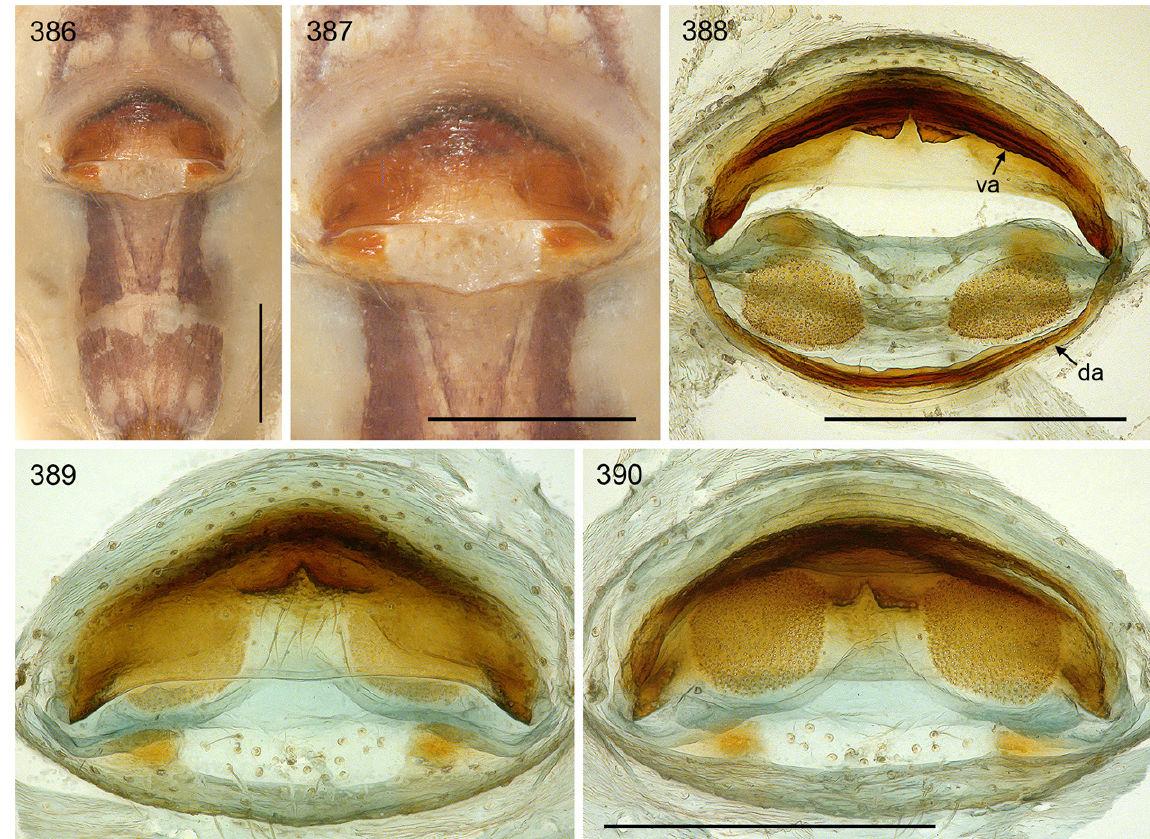
Figs 386–390. Crossopriza illizi sp. nov.; female from Algeria, Aguelmane ti-n-Azzaret (CRB). 386– 387 . Abdomen and epigynum, ventral views. 388–390 . Female internal genitalia, dorsal view (with dorsal arc tilted backwards), ventral view, and regular dorsal view. Abbreviations: da = dorsal arc; va = ventral arc. Scale bars = 0.5